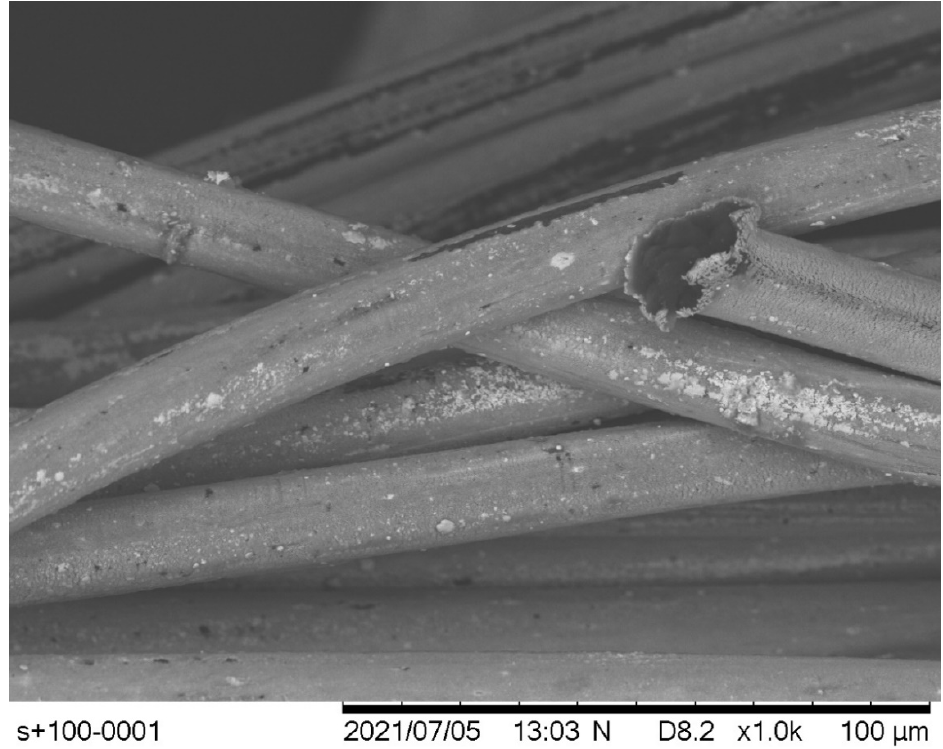
Figure 5. A sample of Silver-tech+ 100 post-fracture. Once again, the severely damaged silver-coating layer has not entirely disappeared after the break.